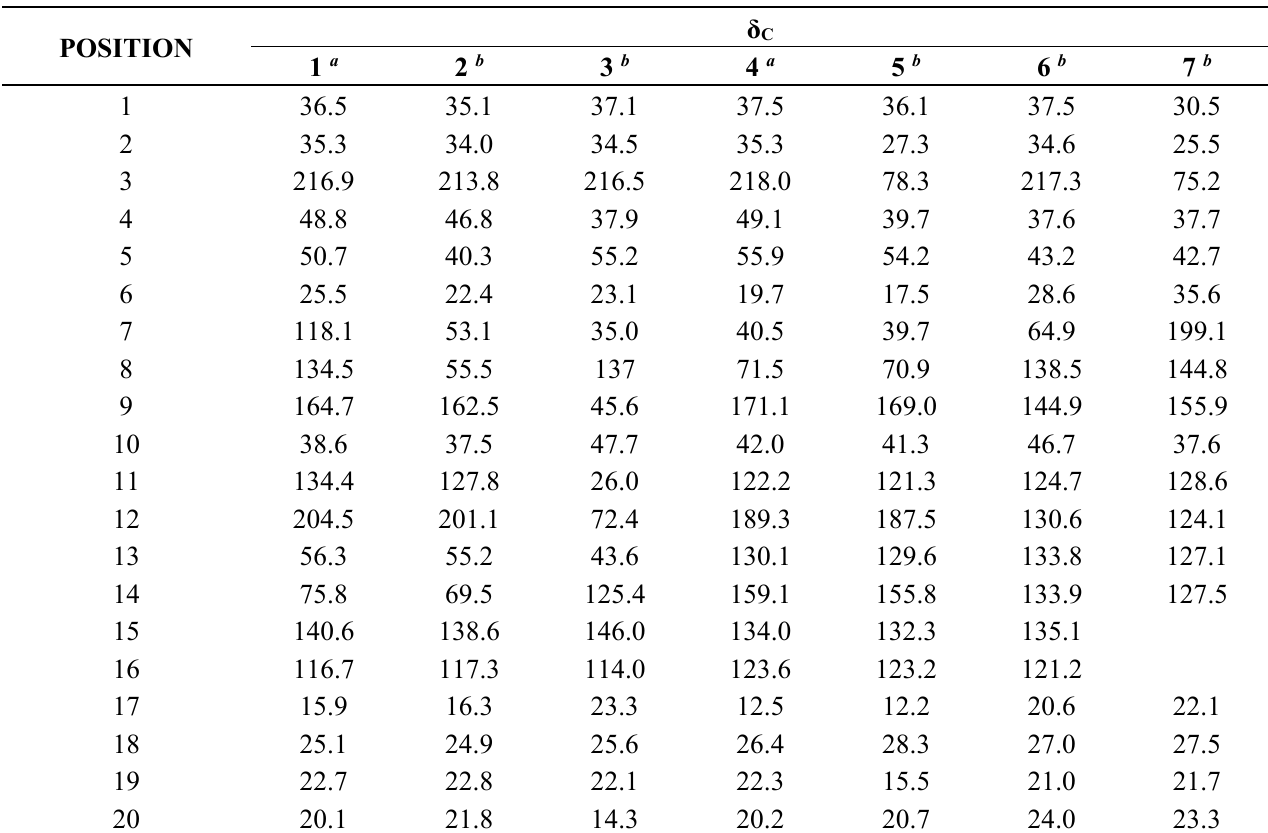
Table 2. 13 C-NMR Data of Compounds 1 − 7